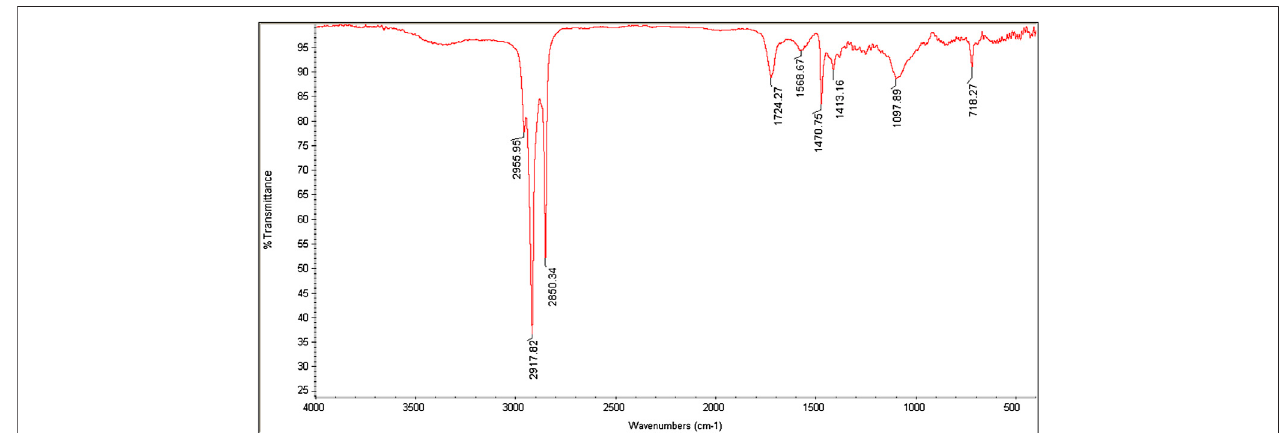
FIGURE 3 | FTIR spectra of